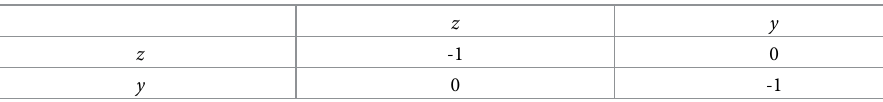
Table 5. Updated matrix A for posets in Fig 10. z y z